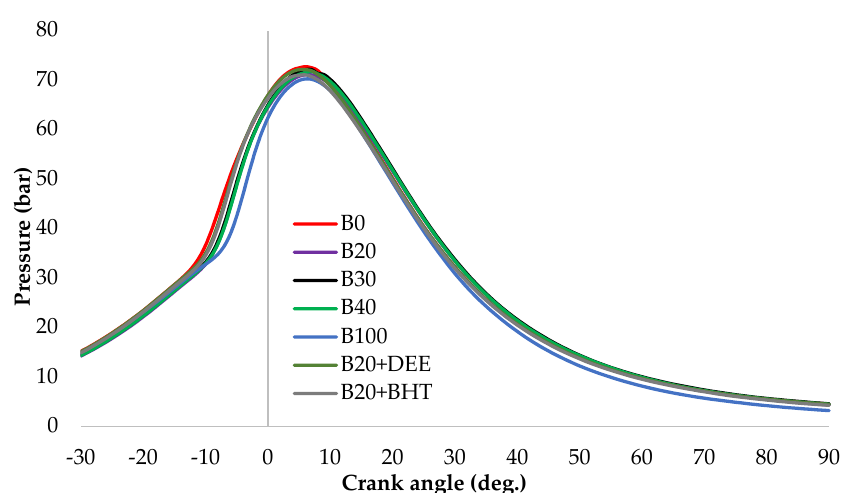
Figure 7. In-cylinder pressure for all fuel blends at full load.